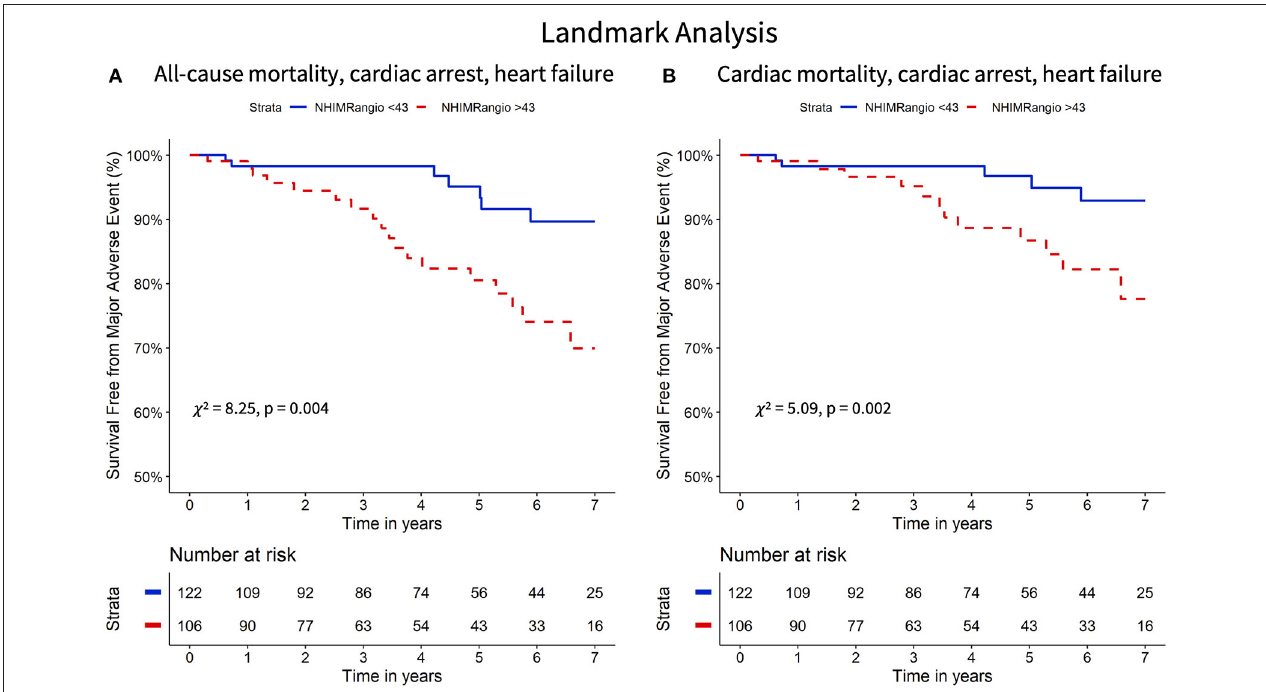
FIGURE 4 | Landmark analysis (30 days onward) Kaplan Meier curves of freedom from all-cause mortality, resuscitated cardiac arrest, new heart failure diagnosis (A) and cardiac mortality, resuscitated cardiac arrest and new heart failure diagnosis (B) stratified according to high versus low NH IMR angio . NH IMR angio , non-hyperaemic IMR angio